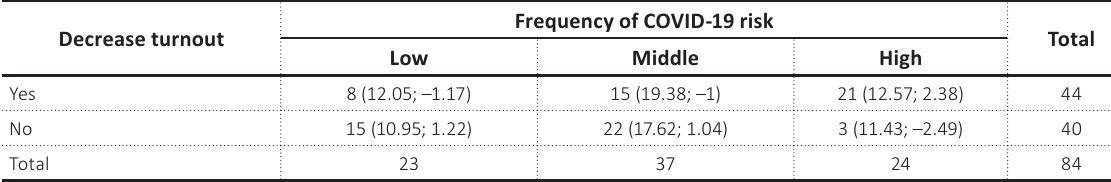
Table 3. Payment morale and the decline in exports Decrease turnout